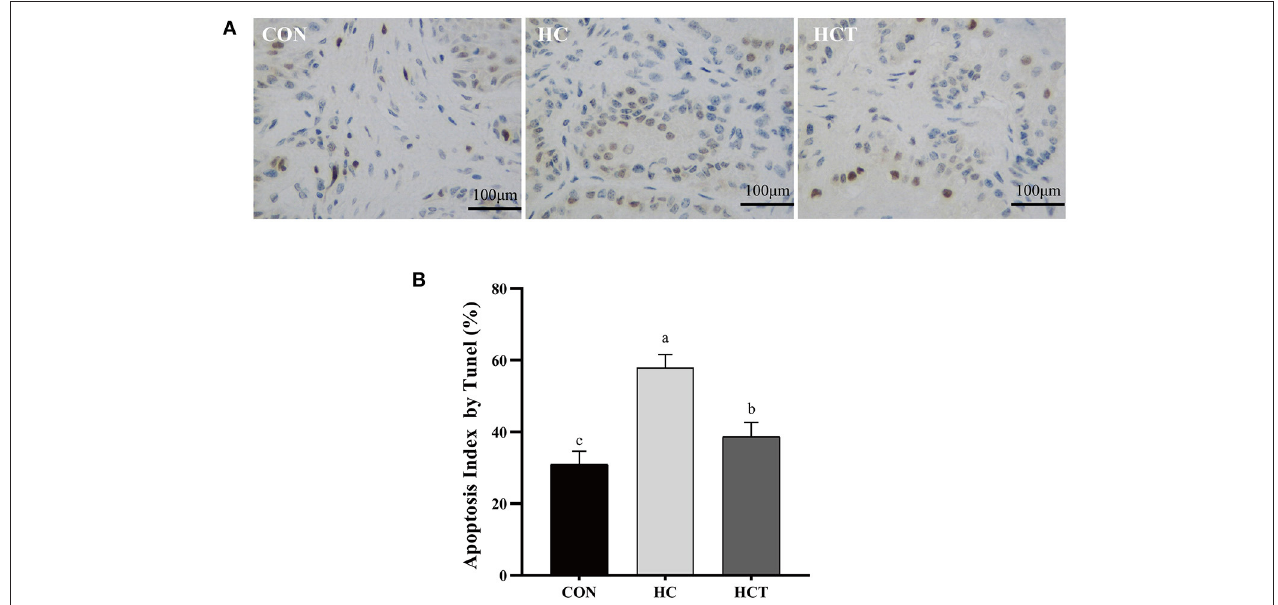
FIGURE 4 | TUNEL comparison of the ruminal epithelium from the low-concentrate diet (CON), high-concentrate diet (HC), and high-concentrate diet with thiamine (HCT) treatments. Ruminal epithelium samples from each treatment were processed for evaluation of TUNEL-positive apoptotic cells. (A) Representative sections of rumen from the different treatments (CON, HC, and HCT treatments). (B) Apoptosis index analysis. All scale bars represent 25 µ m ( n = 8 goats/treatment). The mean values in columns without a common superscript letter differ ( P < 0.05).